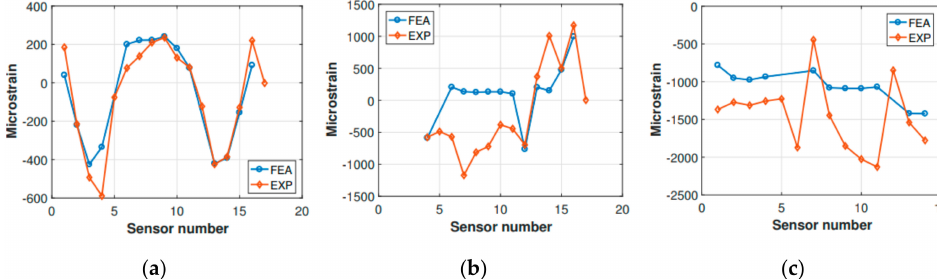
Figure 18. Experimental (EXP) vs. FEA strain comparison for ( a ) frame 7, ( b ) frame 10 and ( c ) tail